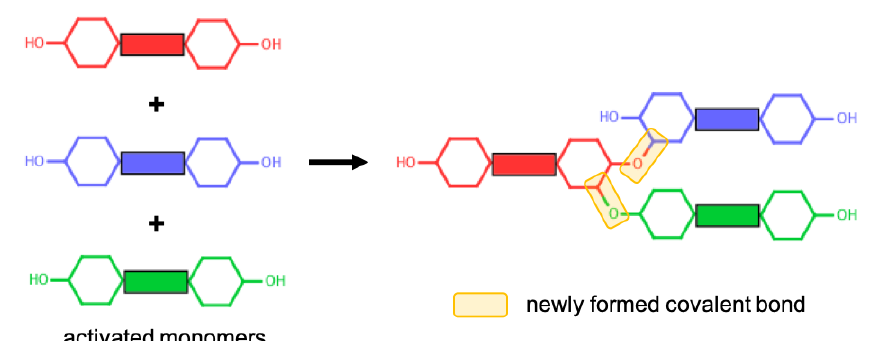
Figure 2. A representative reaction mechanism taking place between